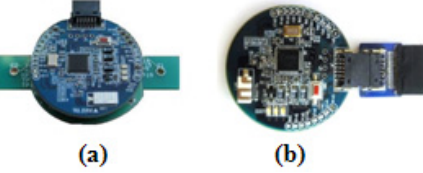
Figure 2. Sensor nodes: ( a ) Sensor node on ECG module; ( b ) Wireless dongle on smart phone.